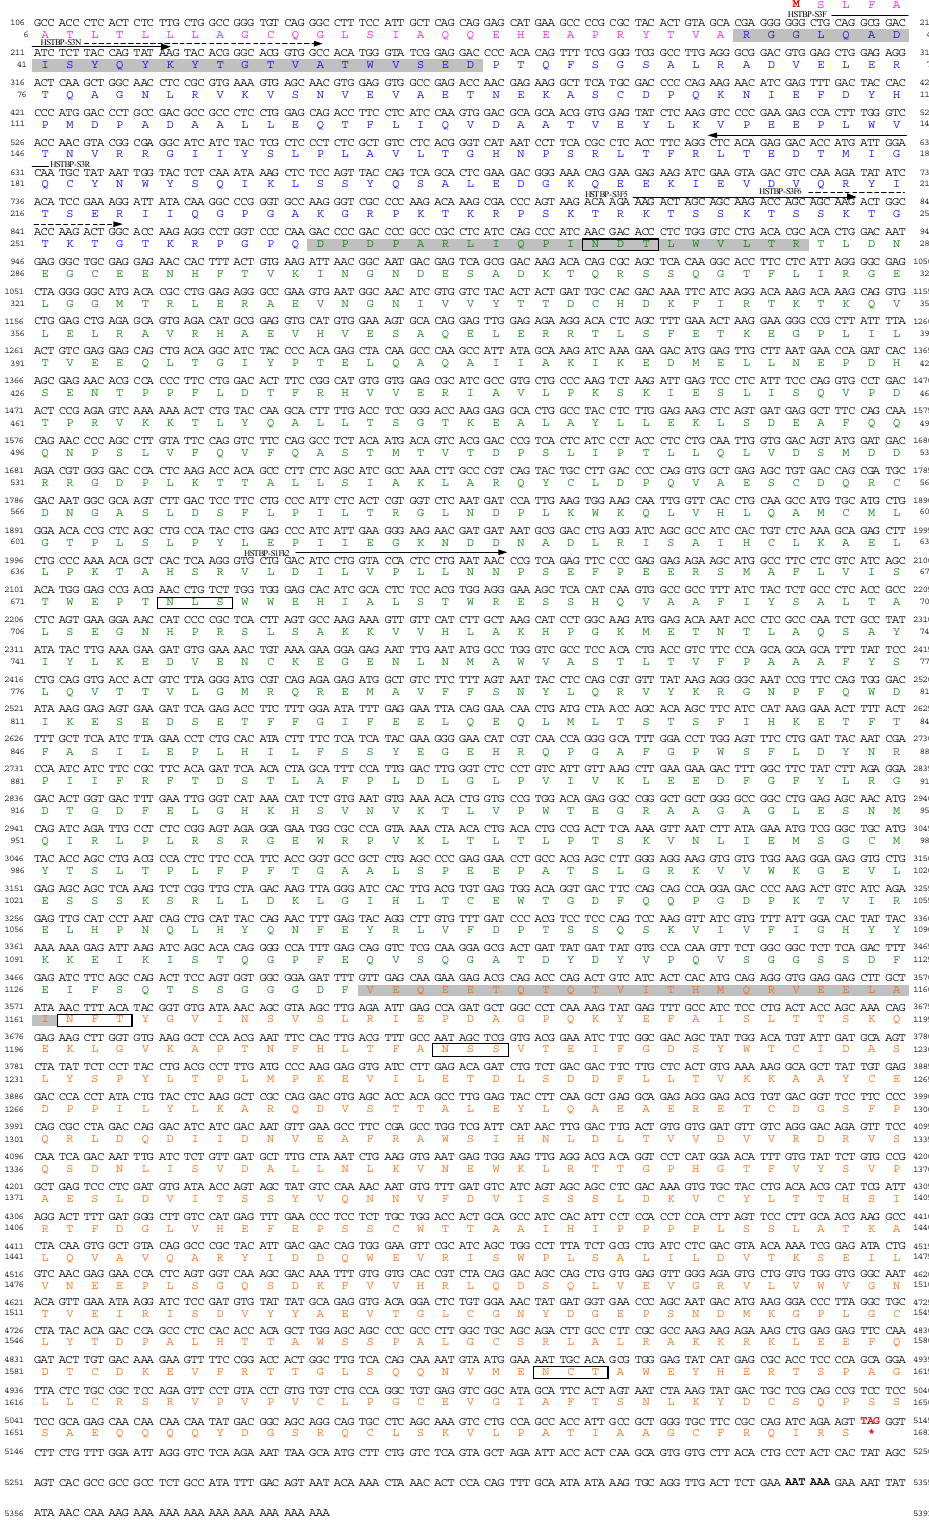
Figure 3. Nucleotide and deduced amino acid sequence of cDNA. N-terminal amino acid sequences of TTX-binding protein subunits are shown in gray. Underlines indicate primers. Protein N-glycosylation site is boxed. Amino acids marked in magenta, blue, green, and red represent signal peptides and cleaved peptides, subunit 3, subunit 1, and subunit 2,